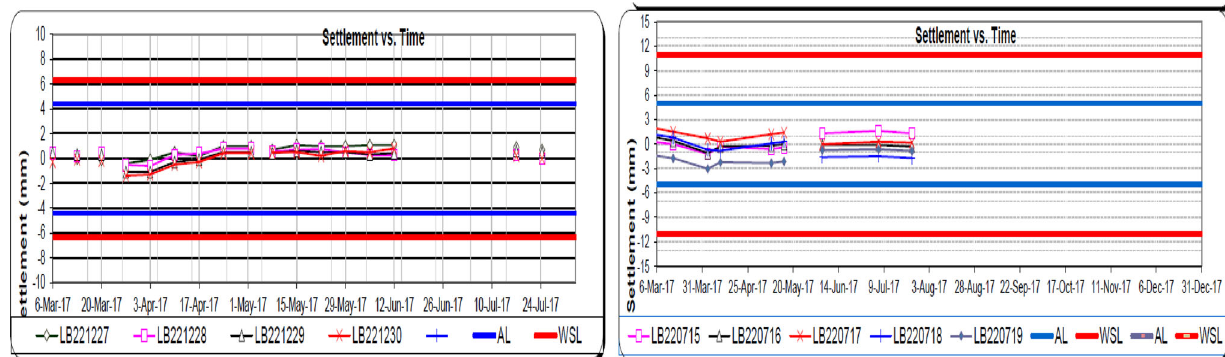
Fig. 12 Trend of settlement markers in the EWL–NEL B3 linkway (left) and EWL station (right)